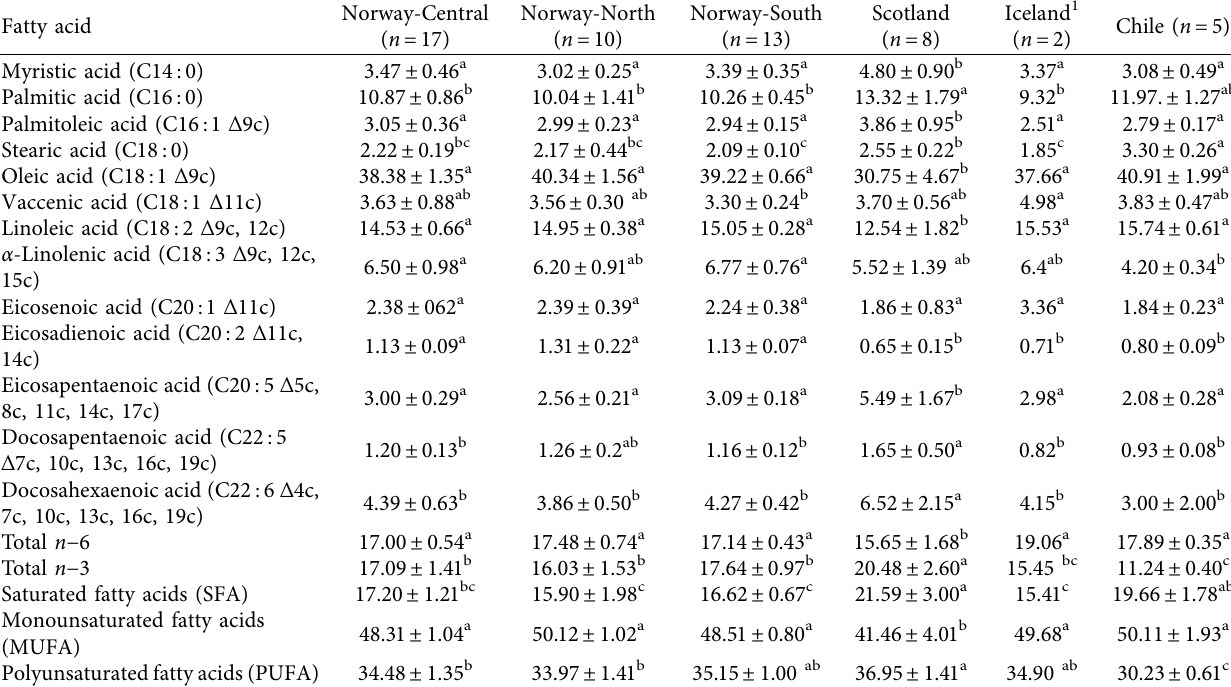
Polyunsaturated fatty acids